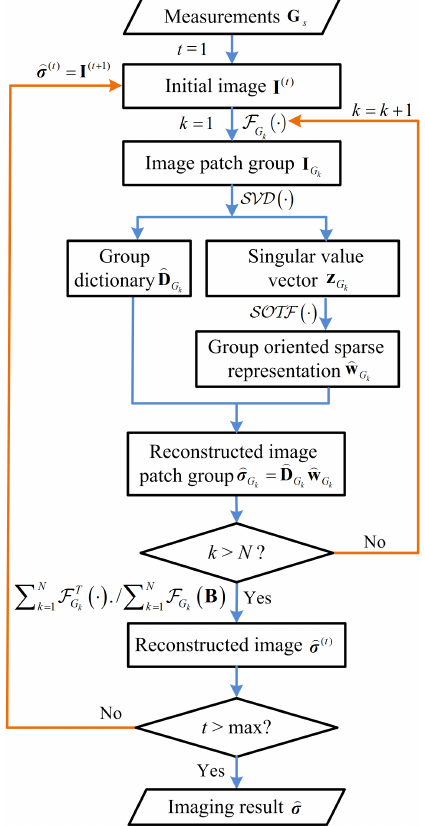
Figure 5. The flow chart of the group dictionary learning based ISAR imaging